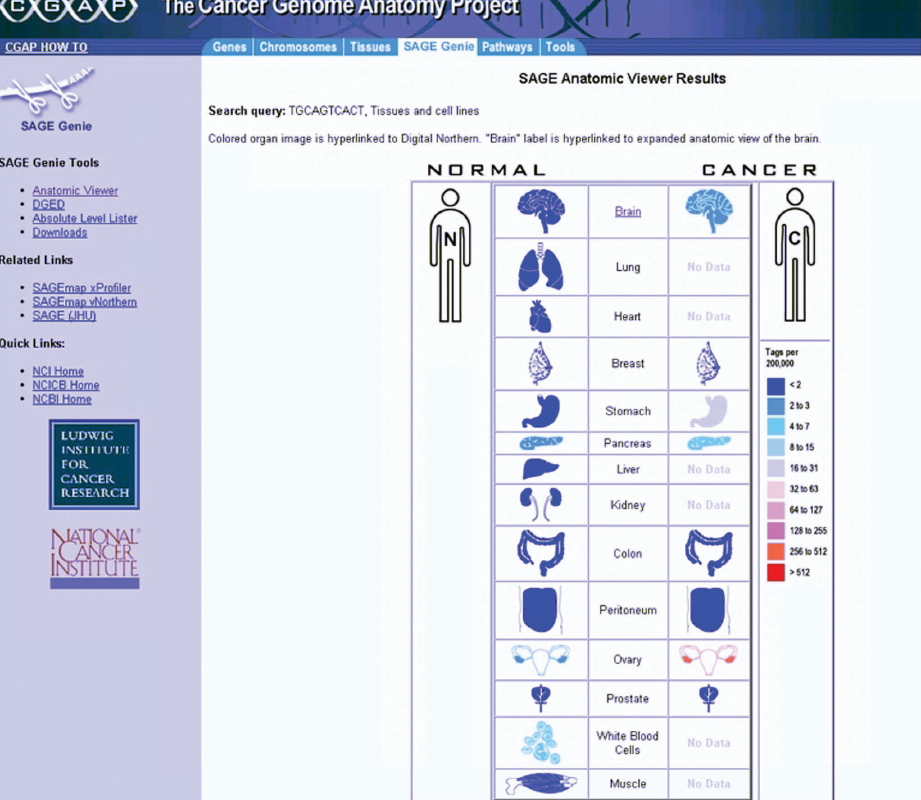
Figure 2. Serial analysis of gene expression (SAGE) anatomic viewer results